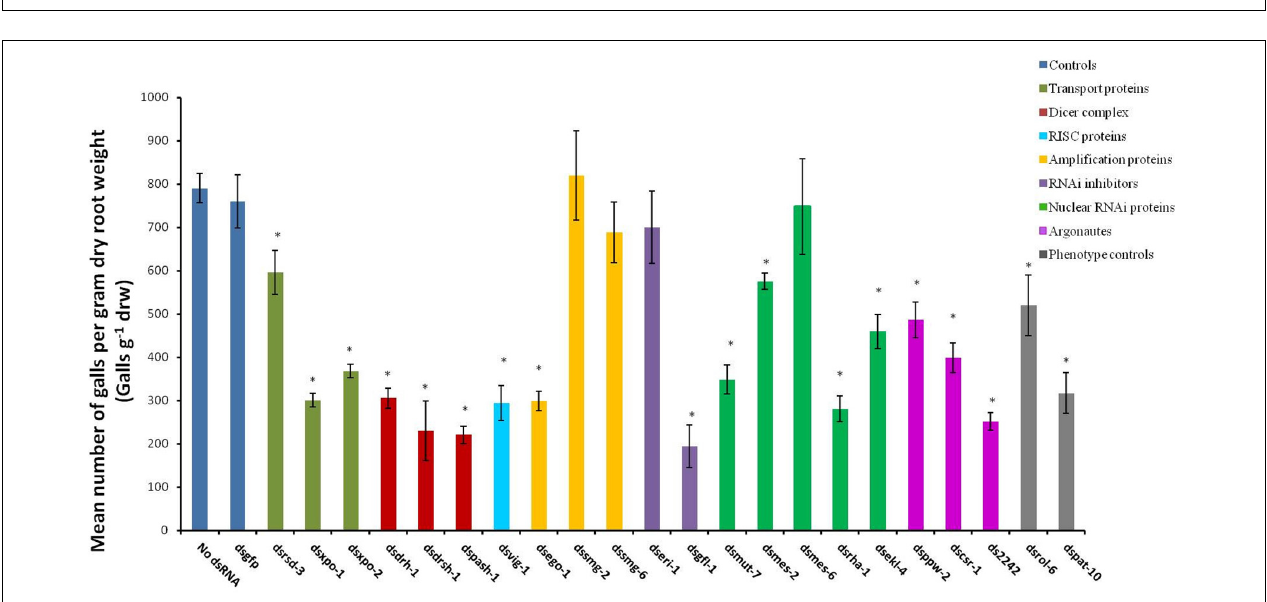
FIGURE 2 | Fold change in target gene expression of M. incognita J2s 16 h after soaking in dsRNA of target genes. Expression in nematodes soaked in dsgfp was used as the baseline. Different colored bars represent different groups of genes involved in the small RNA pathway of the nematode. Bars represent mean fold change in expression with standard error of the means representing three biological replicates (significance ∗ p < 0.05).